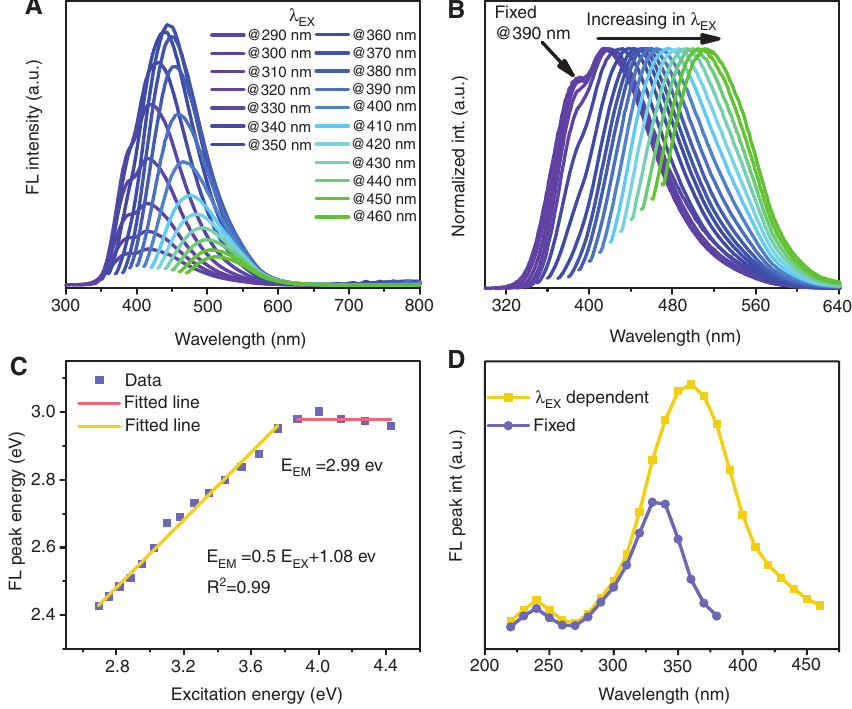
Figure 6: (A) FL emission spectra of NGQDs excited by various wavelengths ranging from 290 to 460 nm. (B) Normalized FL emission spectra of NGQDs derived from part (A). (C) Linear dependence of the FL emission peak energy on excitation energy. (D) Relationship between the intensity of two FL emission peaks ( λ dependent and fixed) and various excitation EX